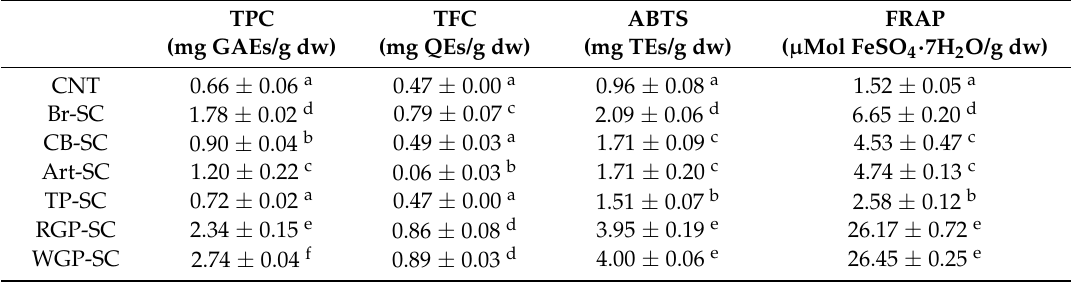
Table 2. Total phenolic content (TPC), total flavonoids content (TFC), and antioxidant activity measured by ABTS and FRAP assays of spreadable cheese enriched with 5% by-products. TPC (mg GAEs/g dw)